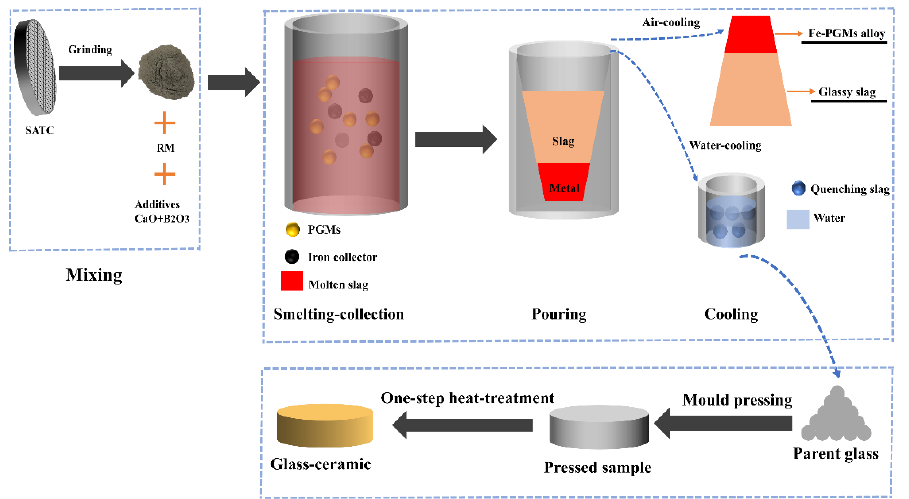
Figure 2. The simple flow diagram of the proposed technology in this study.